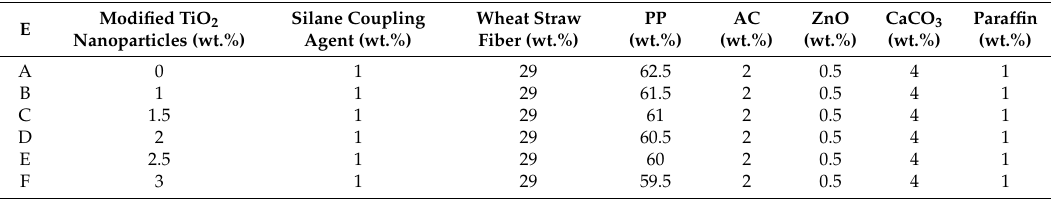
Table 1. Formulations of various samples for the preparation of the foamed wheat straw fiber/PP composites.